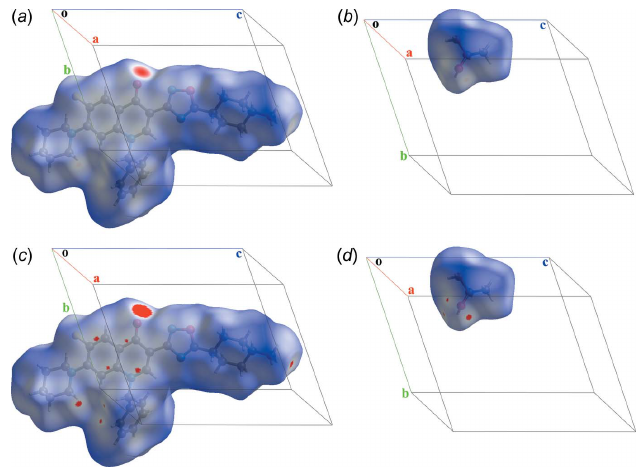
Figure 4 Distribution of the value d norm onto the Hirshfeld surfaces of the title compound ( a , c ) and isopropyl alcohol ( b , d ) with default normalization ( a , b ) and renormalized ( c , d ) for position A .